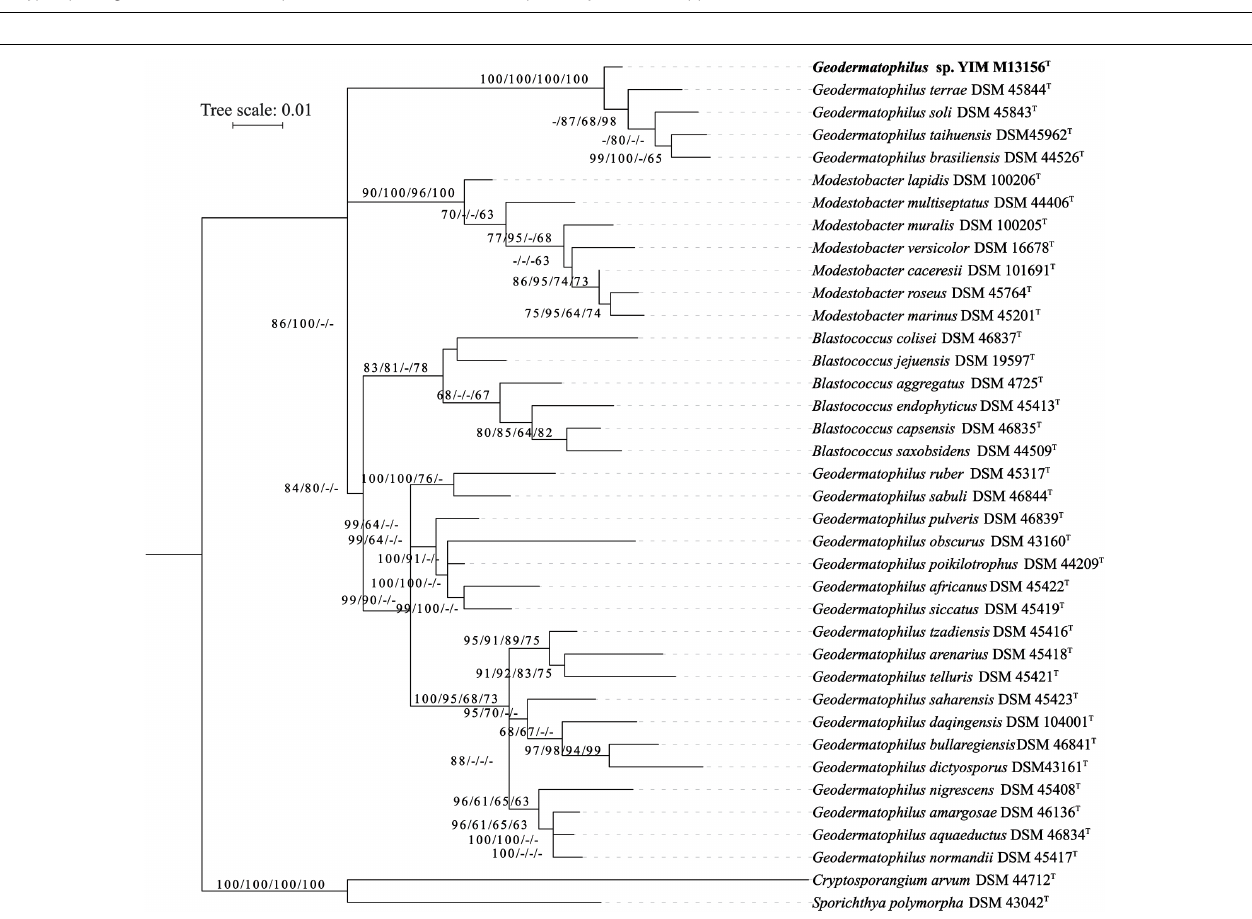
FIGURE 2 | Maximum likelihood phylogenetic tree inferred from 16S rRNA gene sequences, showing the phylogenetic position of the strain YIM M13156 T relative to the type strains within Geodermatophilaceae . The branches are scaled in terms of the expected number of substitutions per site (see size bar). Support values from maximum-likelihood constrained (first), maximum-parsimony constrained (second), maximum-likelihood unconstrained (third) and maximum-parsimony unconstrained (fourth) bootstrapping are shown above the branches if equal to or larger than 60%.